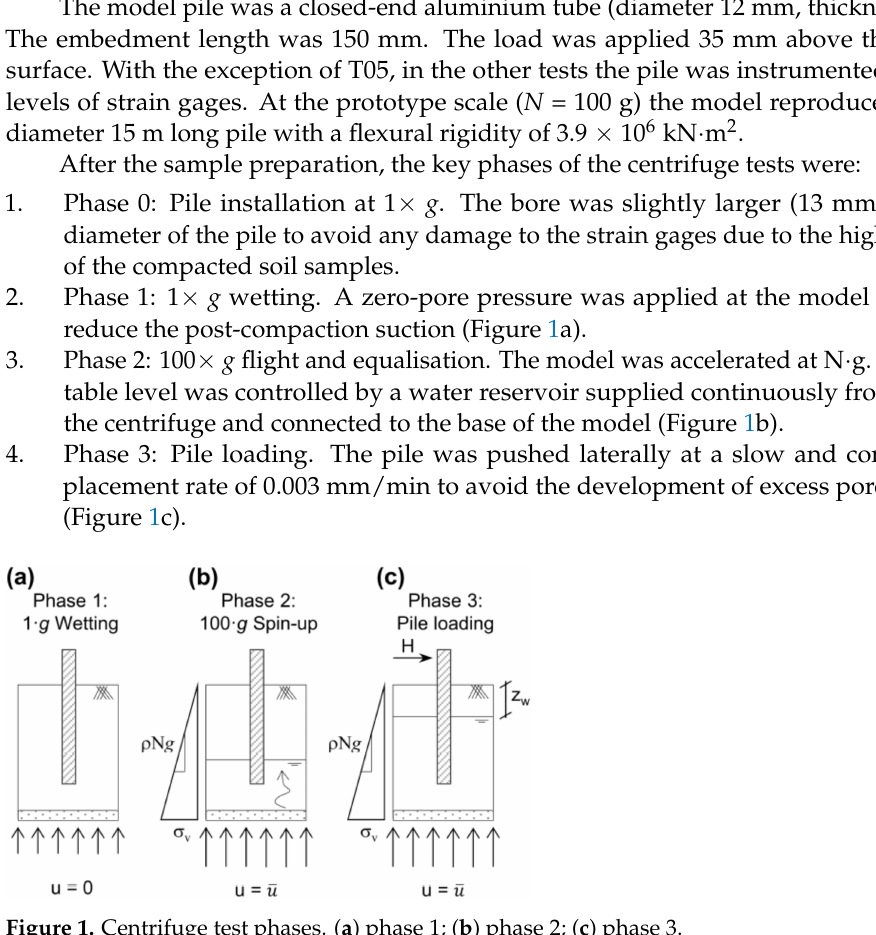
Figure 1. Centrifuge test phases. ( a ) phase 1; ( b ) phase 2; ( c ) phase